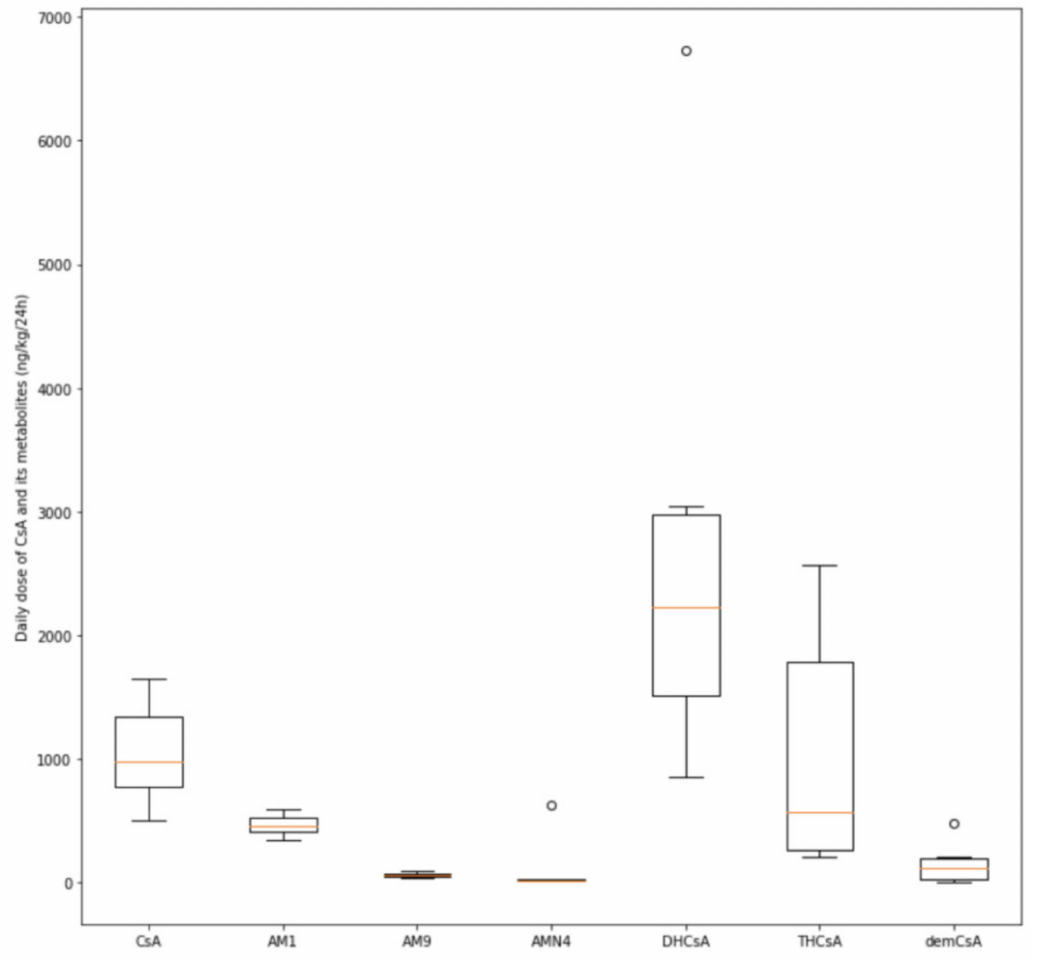
Figure 3. The distribution of daily doses of cyclosporine A (CsA) and its monohydroxylated (AM1, AM9) dihydroxylated (DHCsA), trihydroxylated (THCsA), demethylated (AMN4), and demethylated- carboxylated (demCsA) metabolites per kilogram of body weight (ng / kg / 24 h), ◦ = outlier